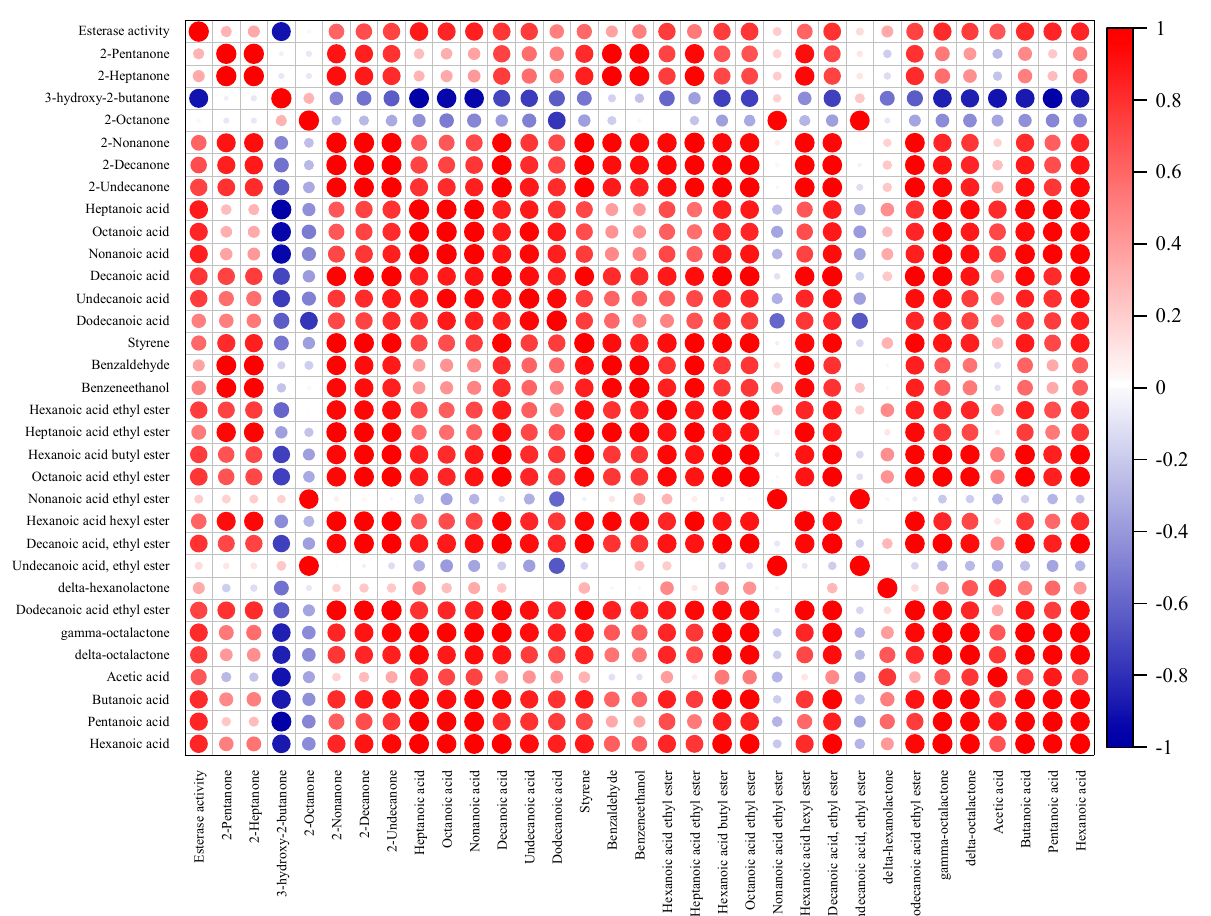
Figure 5. Correlation matrix between the 33 key aroma compounds and the esterase activity of MC. All the Pearson coefficients shown in the matrix are significant ( p <